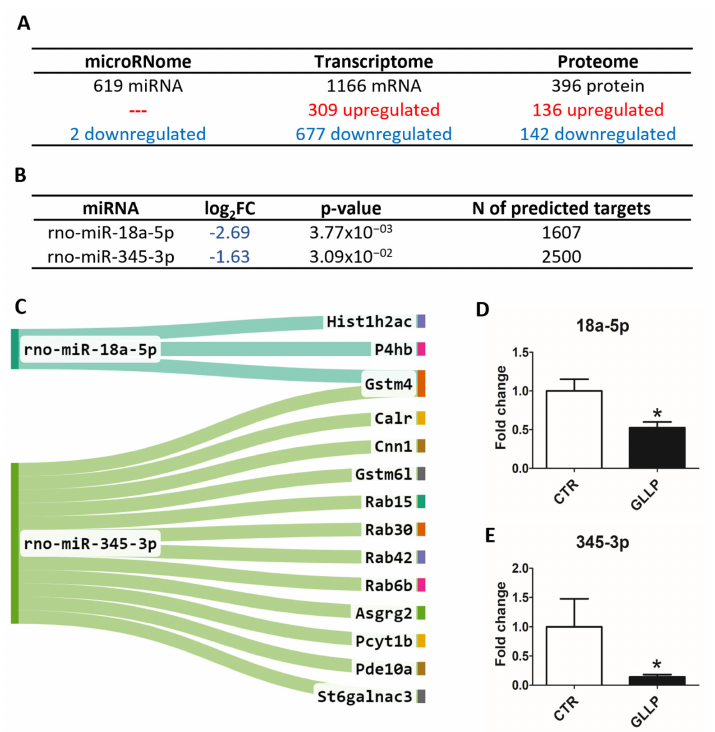
Figure 2. ( A ) Representative image of the differential expression of the multiomic data in the offspring VP from the GLLP group compared to the CTR group at PND 540 (for detailed data, see Supplementary Tables S1–S3). Data of microRNome and transcriptome (n = 5 from the CTR group and n = 4 from the GLLP group. Data of proteome (n = 3 for both the CTR and GLLP groups). ( B ) Differentially expressed (DE) miRNAs identified between the GLLP and the CTR groups. The criteria used to identify DE miRNAs were Log 2 Fold Change ≥ |+0.4| ≤ | − 0.4| and p < 0.05 and base mean > 20. The prediction analysis was performed on the miRWalk 3.0 tool. ( C ) Integrative analyzes using predicted targets of the DE miRNA identified in the VP transcriptome and proteome data from older offspring rats submitted to maternal malnutrition. D and E: RT-qPCR for experimental validation of the DE miRNA miR-18a-5p ( D ) and miR-345-3p ( E ) in the offspring VP. Asterisks mean the statistical difference with p < 0.05. CTR: Control; GLLP: Gestational and Lactation Low